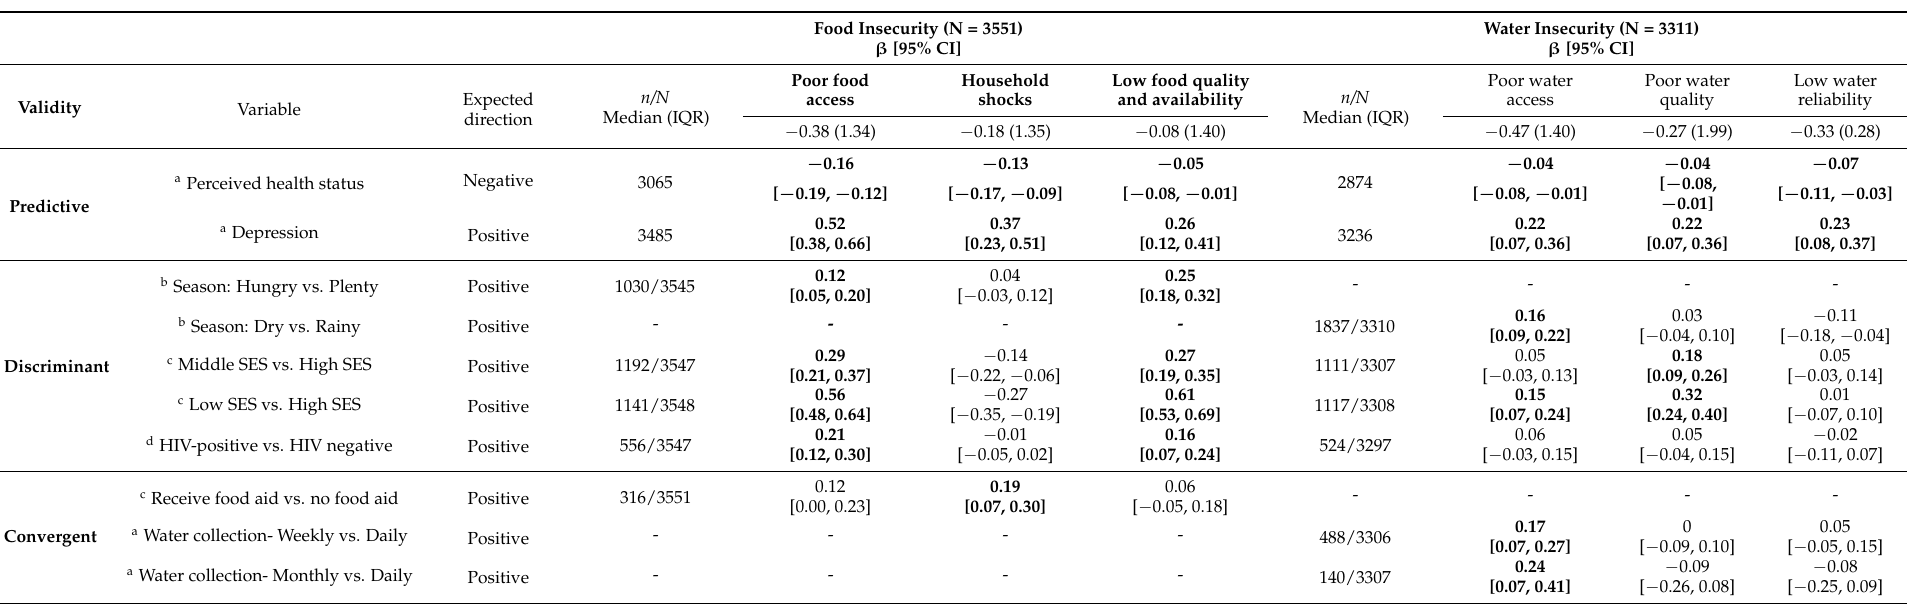
Table 6. Predictive, discriminant and convergent validity of food insecurity and water insecurity